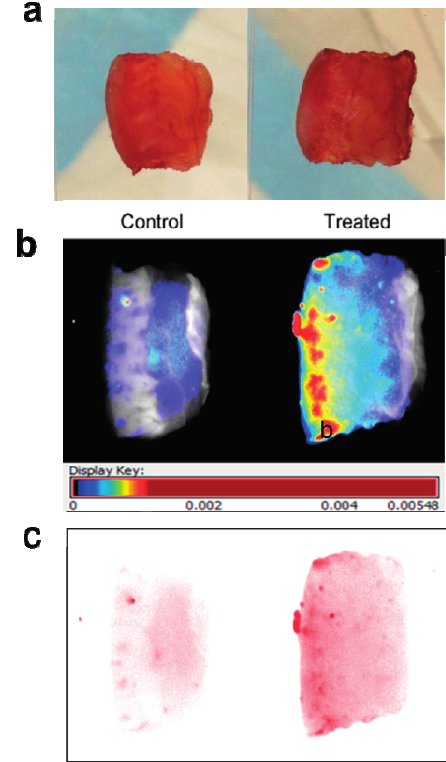
Figure 2. Mounting and imaging of skin specimens. Each pair has the Control specimen on the left (treated with cream only) and the Treated specimen on the right (treated by application of dye-containing nanoparticles in cream). The epidermal surface is on the left for all specimens. Note that ( b ) and ( c ) depict the same pair of specimens, while ( a ) depicts a different pair. ( a ) Skin specimens mounted between glass slides for imaging. Each pair of specimens, after treatment with nanoparticles mixed into skin cream, was mounted between glass microscope slides in a package that compressed the samples uniformly and held them stably in place for imaging on both sides. ( b ) Skin specimens with